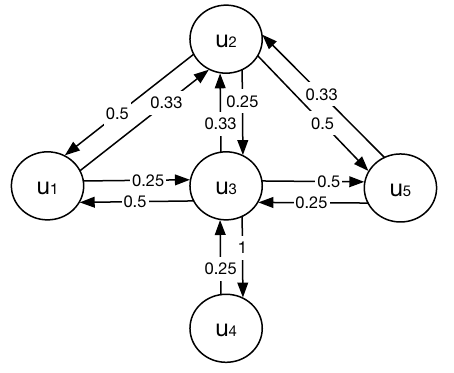
Fig. 1 Influence graph G I with weighted